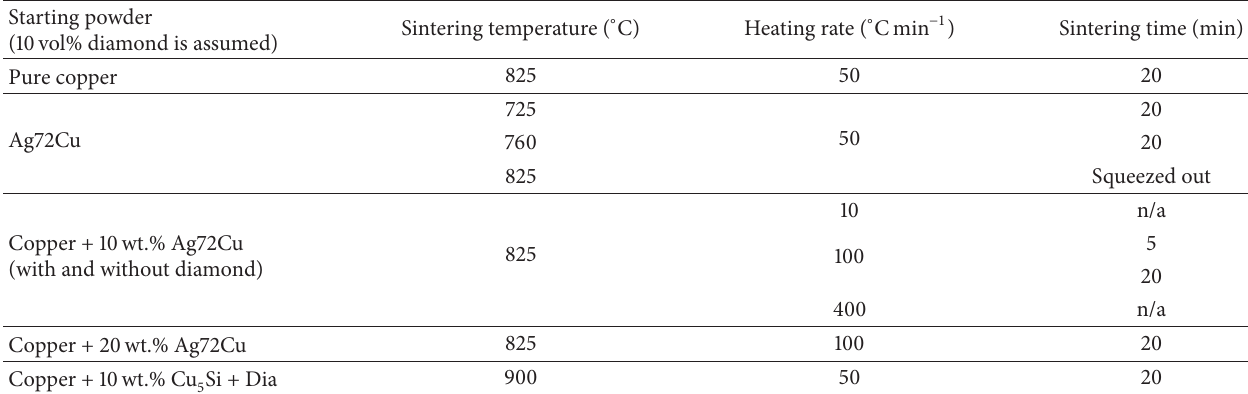
Table 1: Summary of starting powers and processing